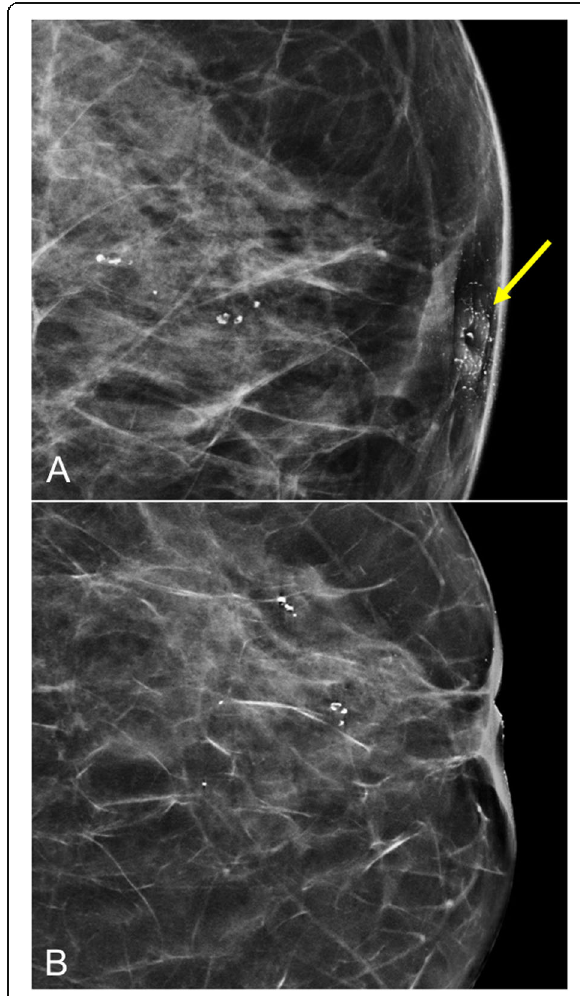
Fig. 8 Pitfall. a Synthesized craniocaudal 2D mammogram shows multiple dense punctiform images at the level of the nipple mimicking calcifications; these artifacts were caused by remnants of body cream. b Repeat image after cleansing the nipple shows the artifacts have